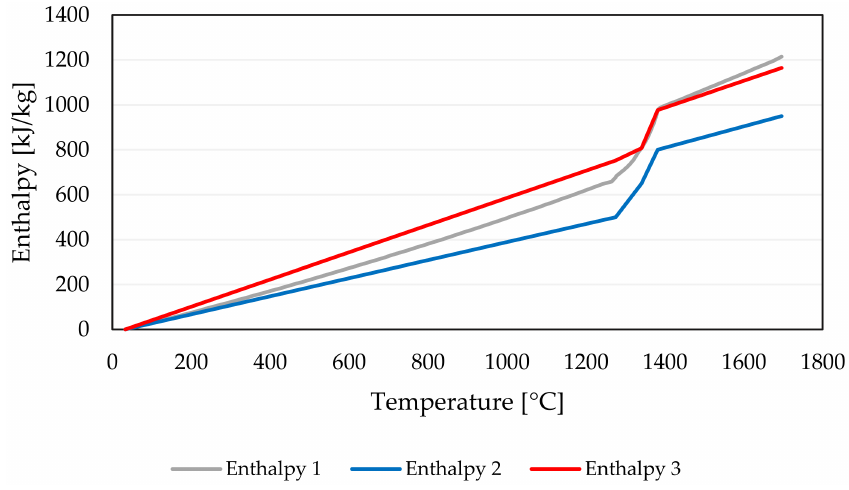
Figure 5. Enthalpy as a function of temperature in the first and last iterations [17].